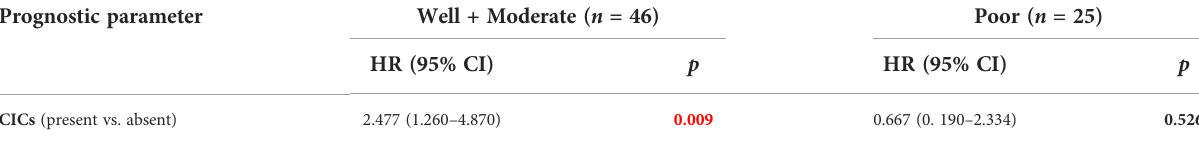
TABLE 5 Multivariate analysis of prognostic parameters for HCC strati fi ed by histological grade. Prognostic